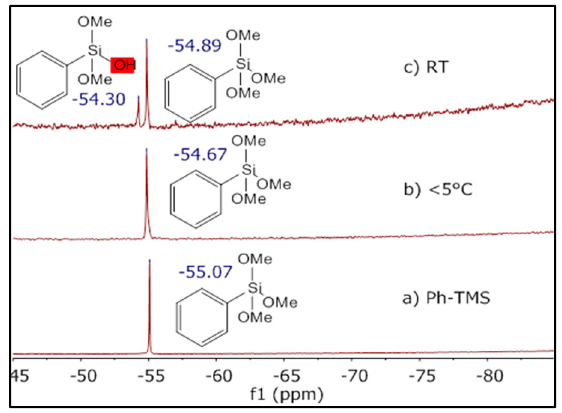
Figure 5. Si-NMR spectra of ( a ) pure Ph-TMS; ( b ) reaction mixture after pretreatment at <5 °C (NMR measurement also at <5 °C); ( c ) reaction mixture after pretreatment at RT.